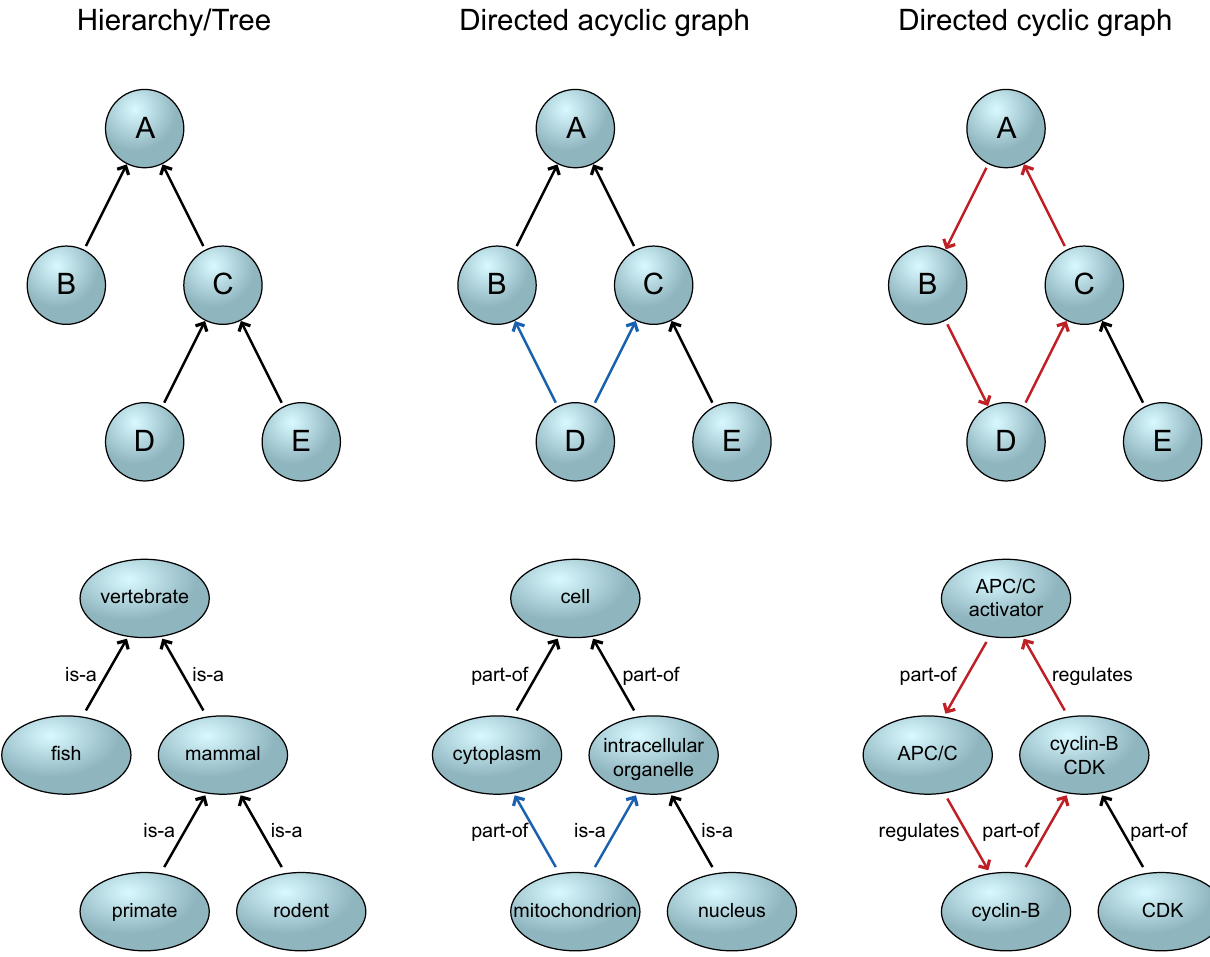
Figure 1. Typical structures of ontologies. Almost all biomedical ontologies are either simple tree structures that represent hierarchical classifications or directed acyclic graphs (DAGs). The difference is that the latter allows a term to be related to multiple broader tems (green arrows) whereas the former does not. Directed cyclic graphs are very rarely used for ontologies; the reason is that cycles (red arrows) can only arise in ontologies that make use of other relationships than is-a and part-of are used [28]. We illustrate each structure with simplified examples, namely an ontology of vertebrates, an ontology of cellular components, and an ontology of cell-cycle regulation that shows the mutual regulation of cyclin- dependent kinase (CDK) and anaphase-promoting complex/cyclosome